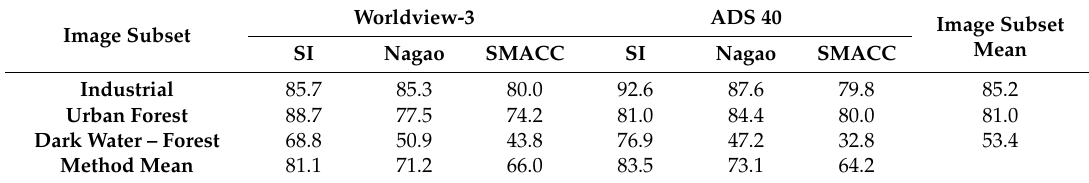
Table 7. F-score results for all three methods on both ADS40 and Worldview-3 images that includes method mean and image subset mean.